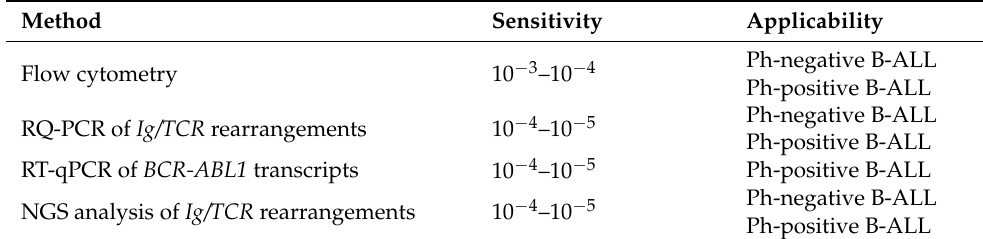
Table 1. Summary of methods currently used for MRD testing in adult